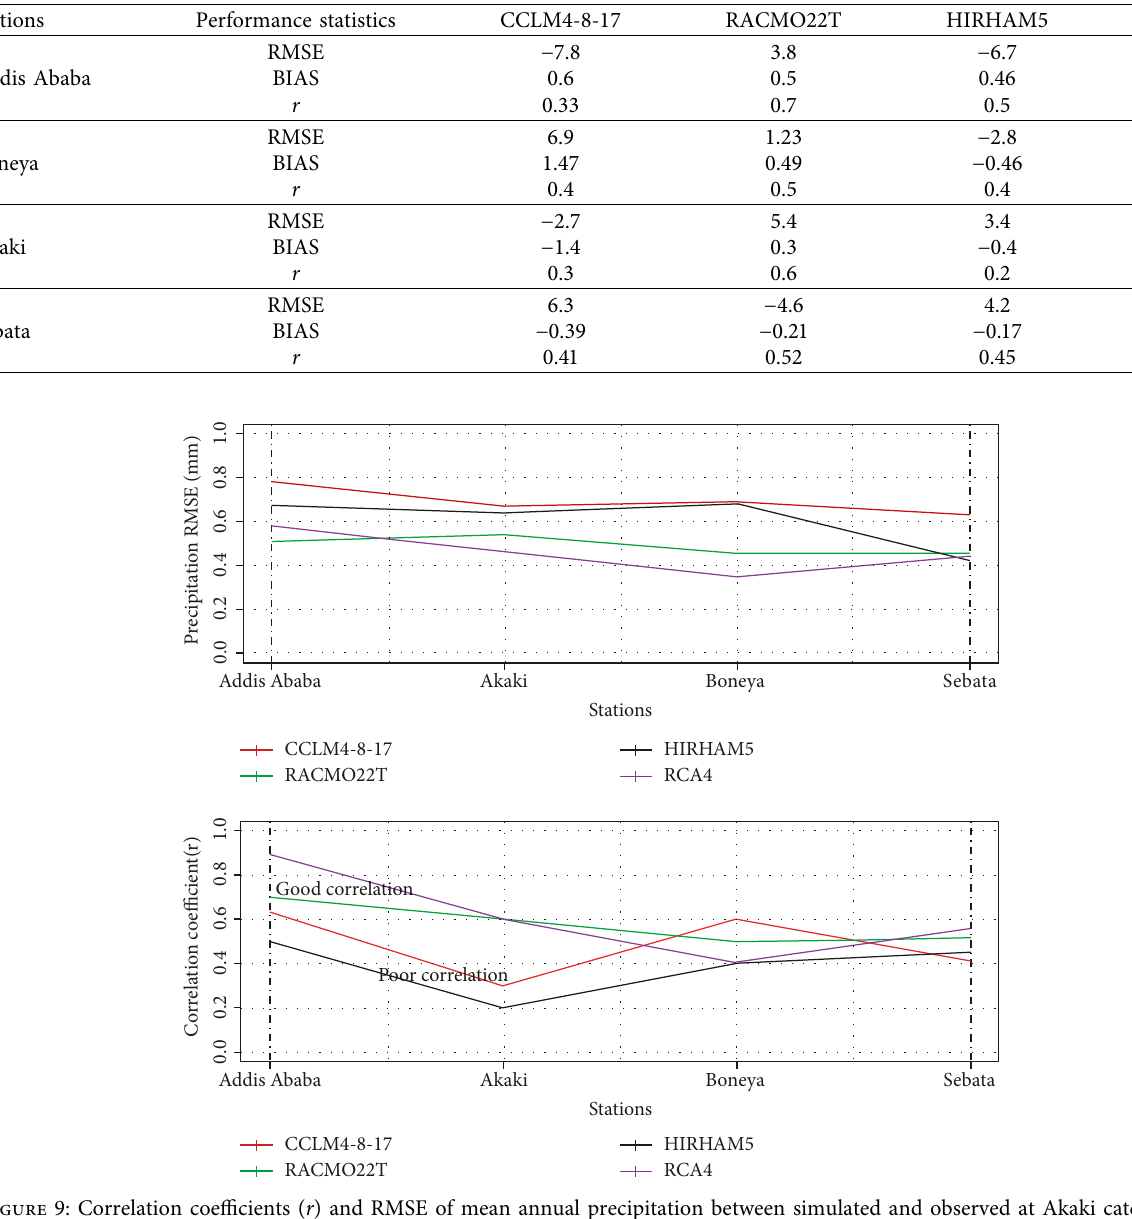
Table 10: Statistical relationship between observed and simulated rainfall on a daily basis.